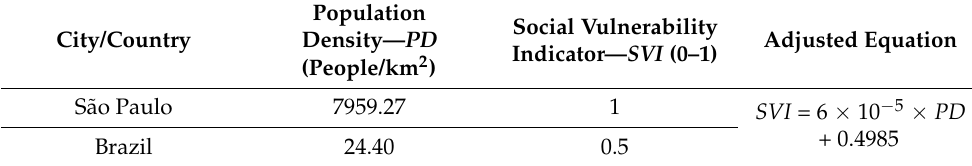
Table 15. Social vulnerability indicator determination.